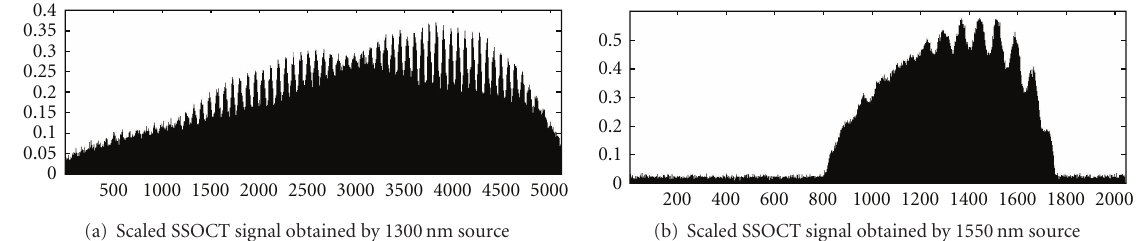
Figure 7: Scaled SSOCT signals of Figure 6. (a) scaled SSOCT signal obtained by 1300 nm source; (b) scaled SSOCT signal obtained by 1550 nm source.